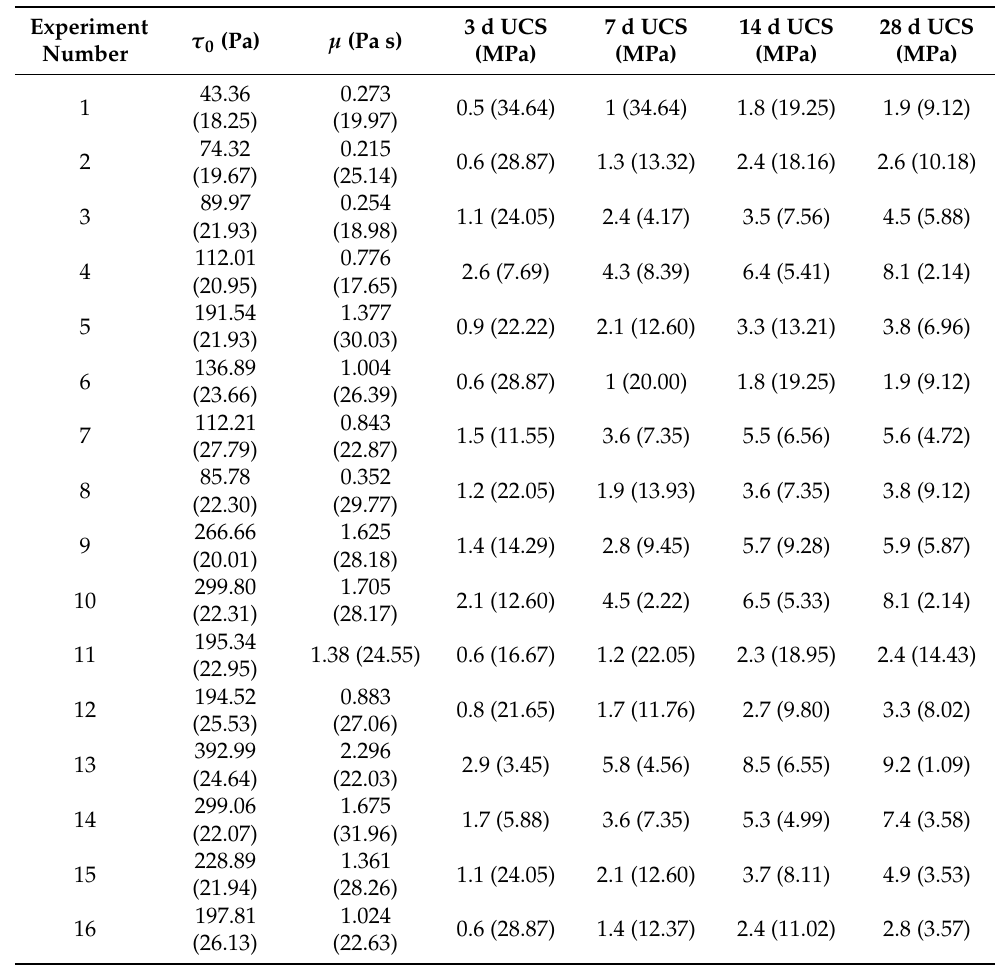
Table 5. Experimental results of rheological properties and UCS